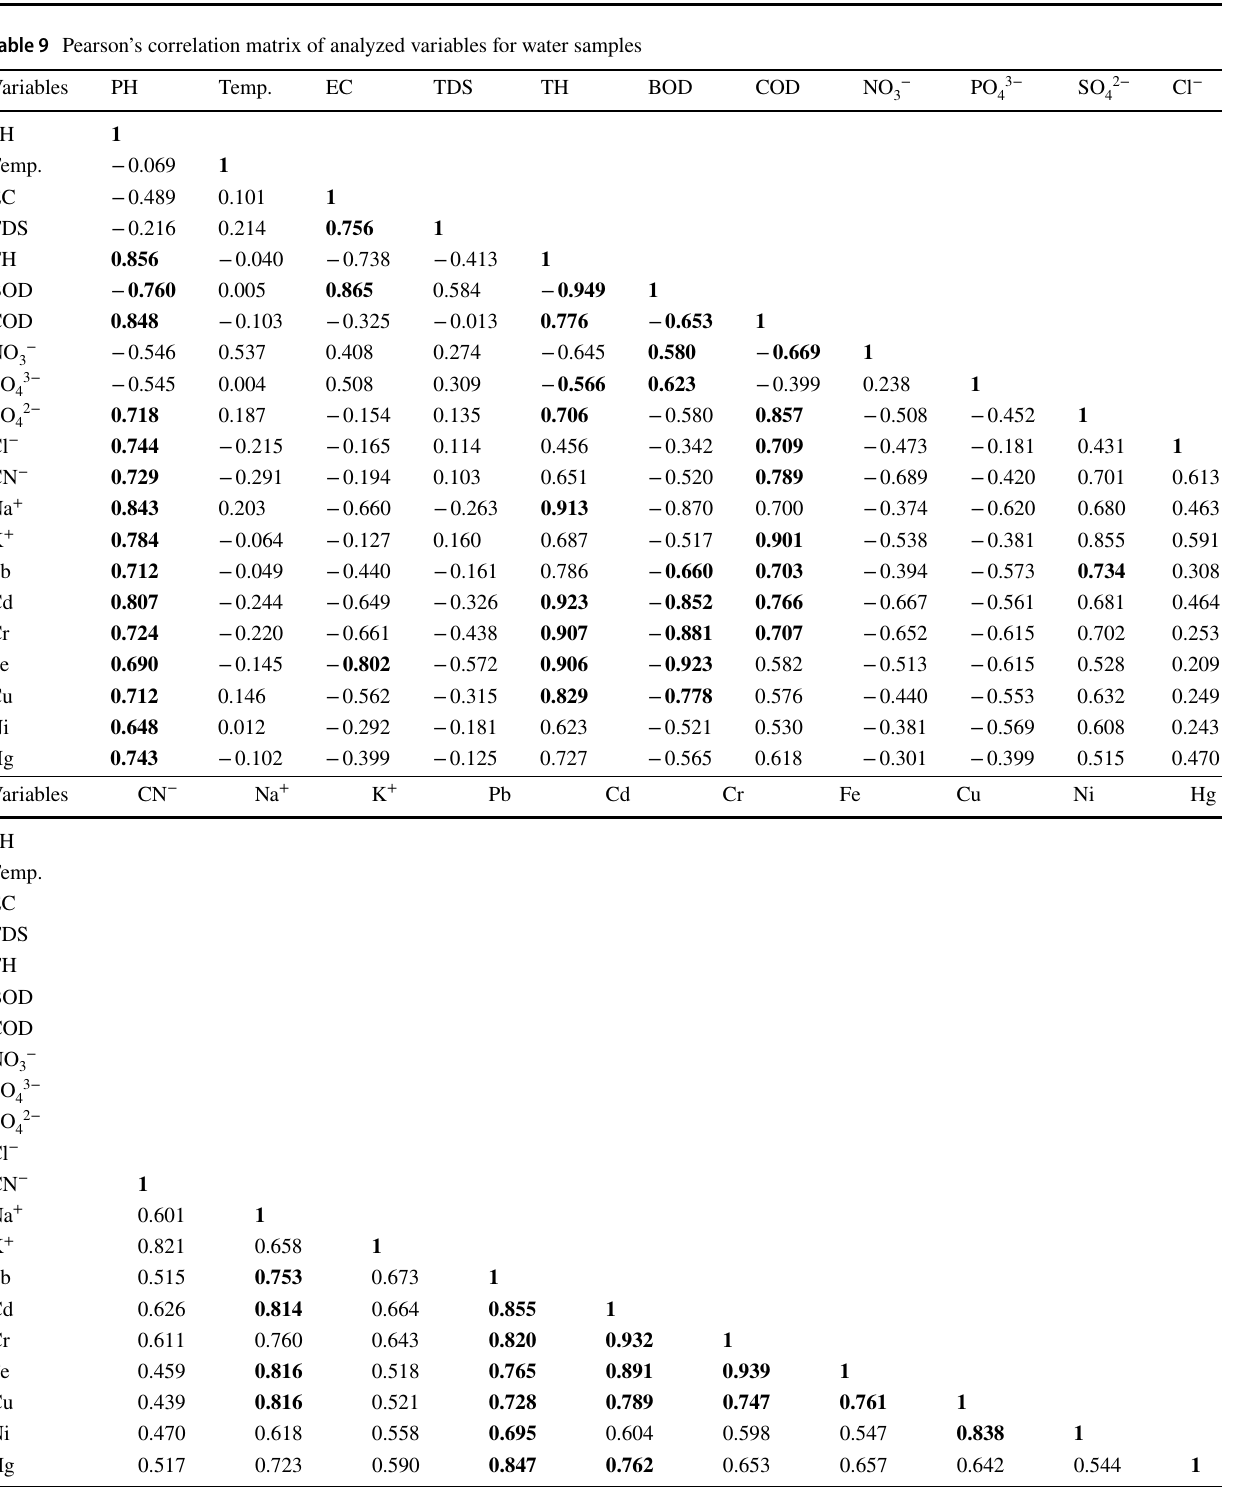
Values in bold are different from 0 with a significance level alpha